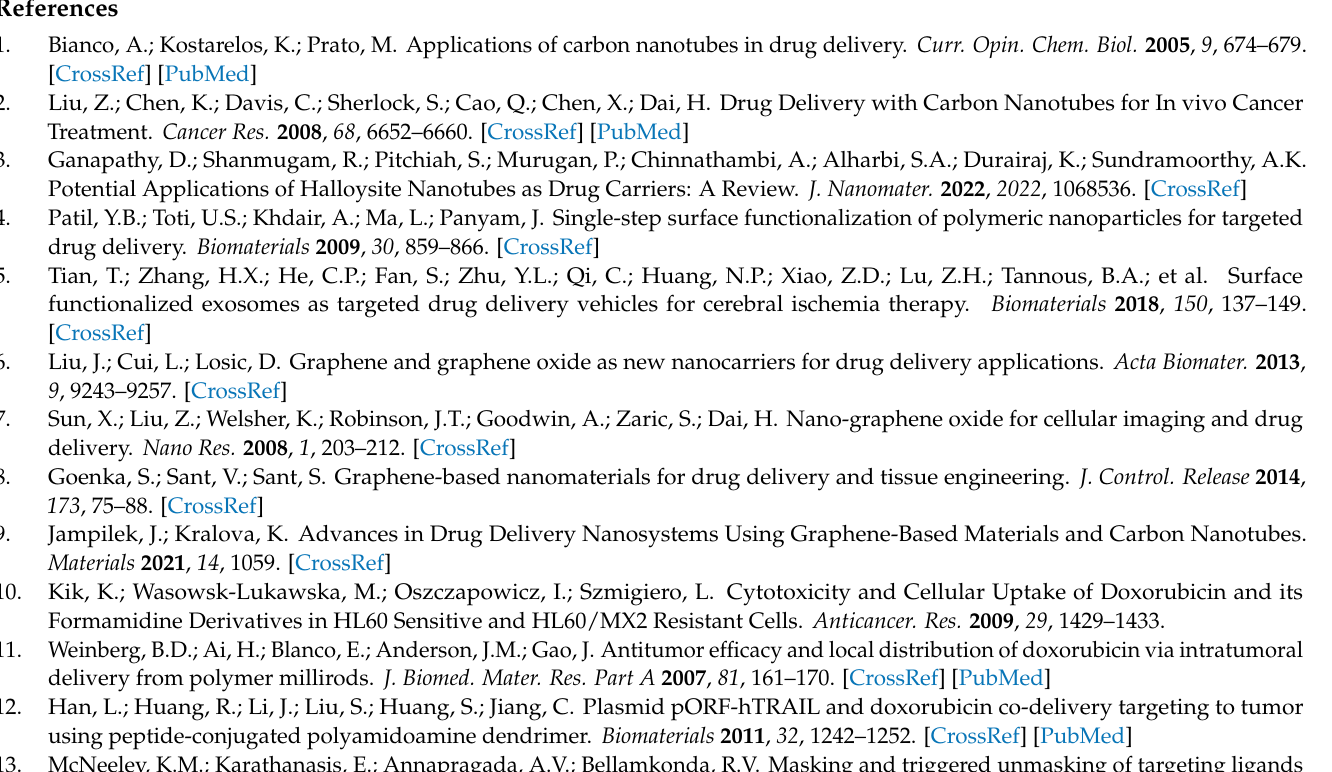
algorithm for interaction between DOXH and graphene. Figure S5: (a) Atomic structure and (b) vector representation for stable configurations of interaction between DOXH and graphene sheet referencing to Cartesian coordinate system. Figure S6: Energy level as a function of (a) offset rotational angles on x- and y-axis and (b) offset distance z and offset rotational angle on x-axis for various positions for interaction between DOXH and graphene of seed III-7. Figure S7: Convergence of algorithms for two DOXHs interacting with graphene. Figure S8: Atomic structure (left column) and vector representation (right column) for (a,b) Type B1, and (c,d) Type B2 for two stable configurations of interaction between two DOXHs and graphene sheet referencing to Cartesian coordinate system. Figure S9: Energy level as a function of offset distance between carbon ring planes and offset rotational angle on z-axis for various positions of (a) seed III-9 for Type B1 and (b) seed III-8 for Type